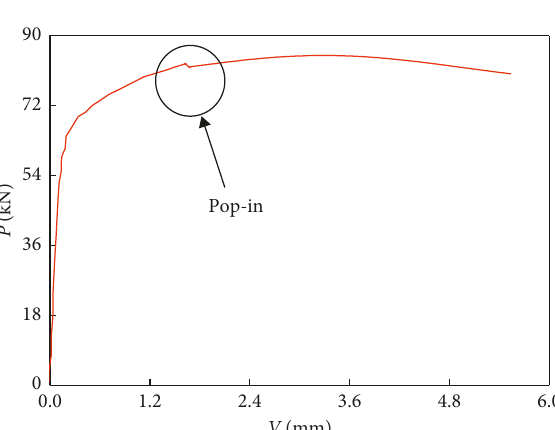
Figure 7: Pop-in phenomenon in P – V of sample H2.